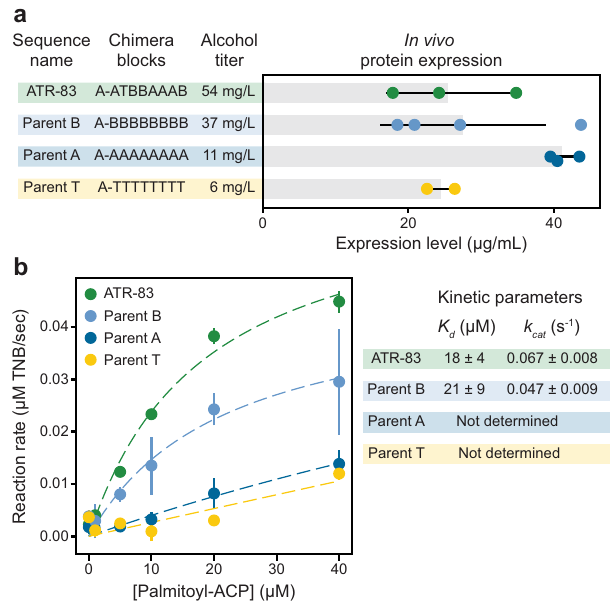
Fig. 3 Expression levels and kinetic activity of selected ATRs. a We measured the expression levels of the ATR-83 chimera and the three parental enzymes. These four enzymes displayed no signi fi cant differences in expression despite the large differences in their alcohol titers. The error bars represent one standard deviation centered at the mean ( n = 3, 4, 3, and 2 for ATR-83, parent B, parent A and parent T, respectively, where n is the number of cultures analyzed, each from individual colonies). b We characterized the kinetics of selected enzymes on palmitoyl-ACP. The error bars represent one standard deviation centered at the mean ( n = 4 technical replicates). ATR-83 displayed a higher turnover number ( k cat ) relative to parent B, and higher activity overall compared to the other parents. The kinetic parameters for parents A and T could not be precisely determined due to their low overall activity and the resulting poor fi t to the Michaelis – Menten model. Source data are provided as a Source Data fi